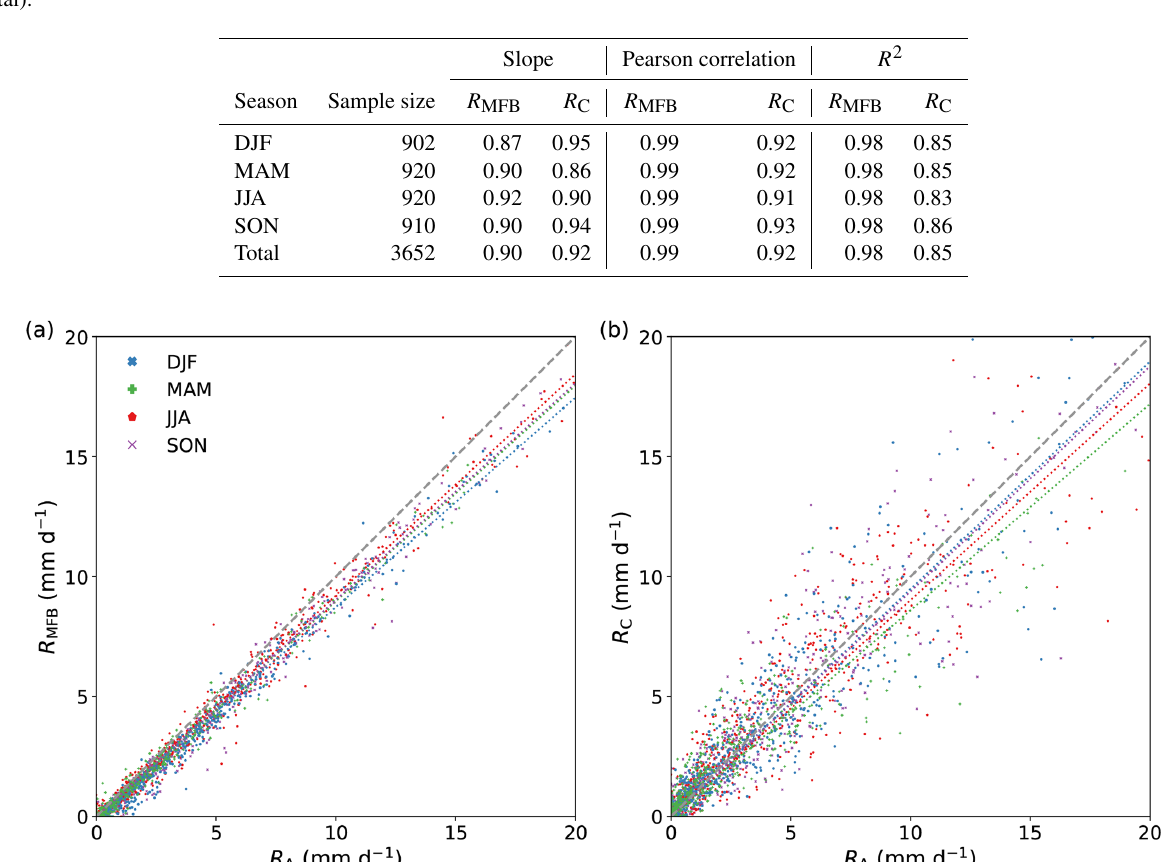
Figure 5. Comparison between the reference rainfall ( R A ) and the two adjusted radar QPE products: (a) R MFB and (b) R C . Shown are the daily country-average rainfall sums based on 10 years (2009–2018), classified per season. The slope, Pearson correlation and sample size per season are indicated in Table 2. The dashed colored lines are a linear fit, forced through the origin, per season between the reference and the two QPE